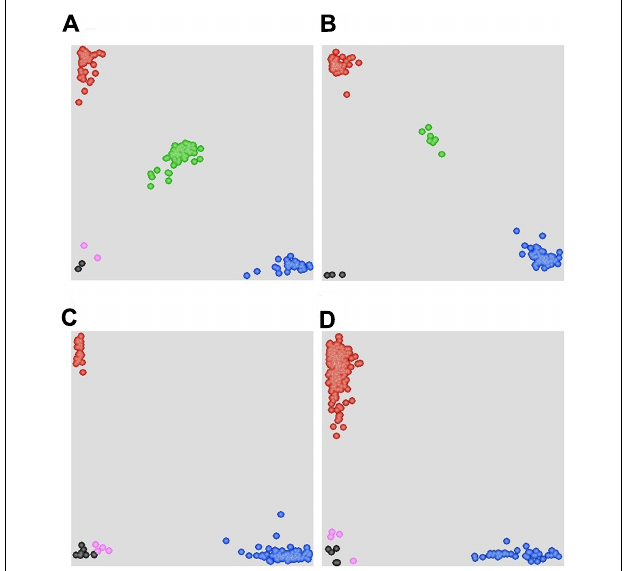
FIGURE 4 | Scatter plots for selected KASP assays showing clustering of F 2 and F 5 : 6 lines on the X - (FAM) and Y - (HEX) axes. (A) Marker 90K-AN34 results for the F 2 : 3 population showing three distinct clusters. The central cluster (green) is comprised of heterozygous individuals, whereas clusters near the axes are homozygous for either AVS (HEX; red) or Napo 63 (FAM; blue). Black dots represent the NTC (non-template control) and pink dots represent missing or failed data. (B) Marker 660K-AN21 results for F 5 : 6 population showing two distinct clusters. (C) Marker 660K- AN65 results for 215 cultivars and landraces showing two distinct clusters. The clusters near the Y-axis are homozygous for the Napo 63 allele (HEX; red). (D) Marker 660K-AN3 for 215 cultivars and landraces showing two distinct